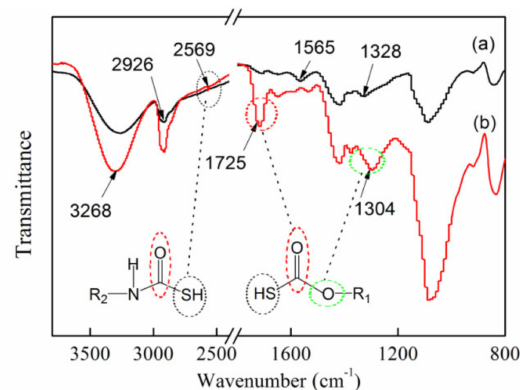
Figure 4. Fourier transform infrared spectroscopy (FTIR) of the CS/PVA/CNC composite nanofibrous films ( a ) before, ( b ) after modification.